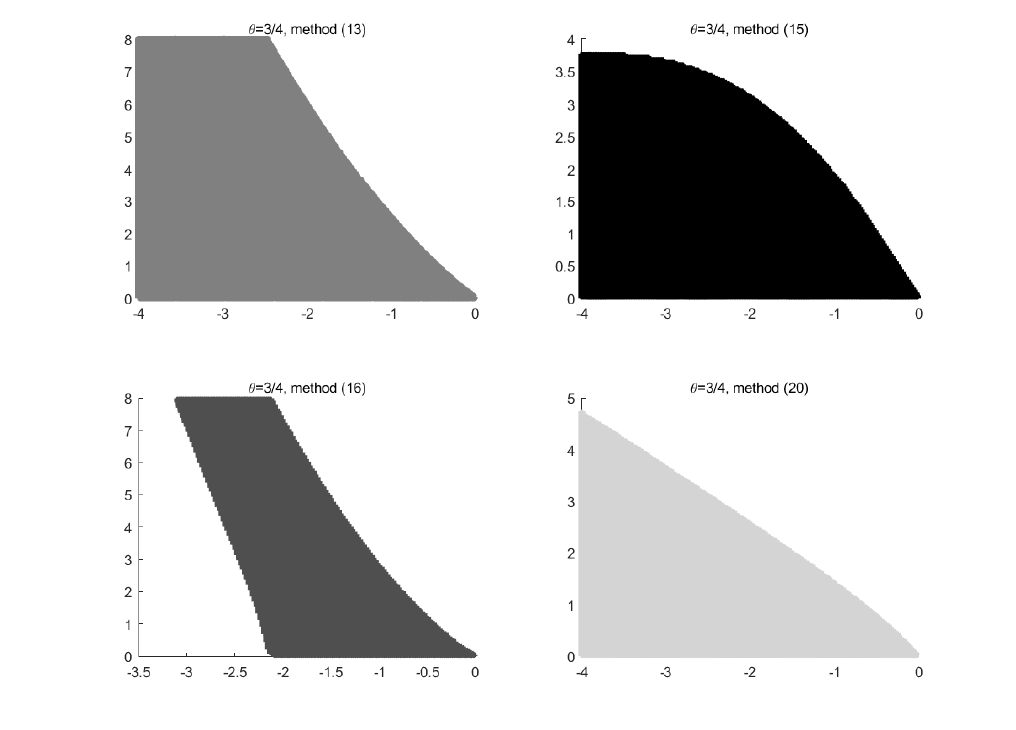
Figure 4. Mean-square stability regions in the ( x , y )-plane with respect to the basic test Equation (11), case ϑ =